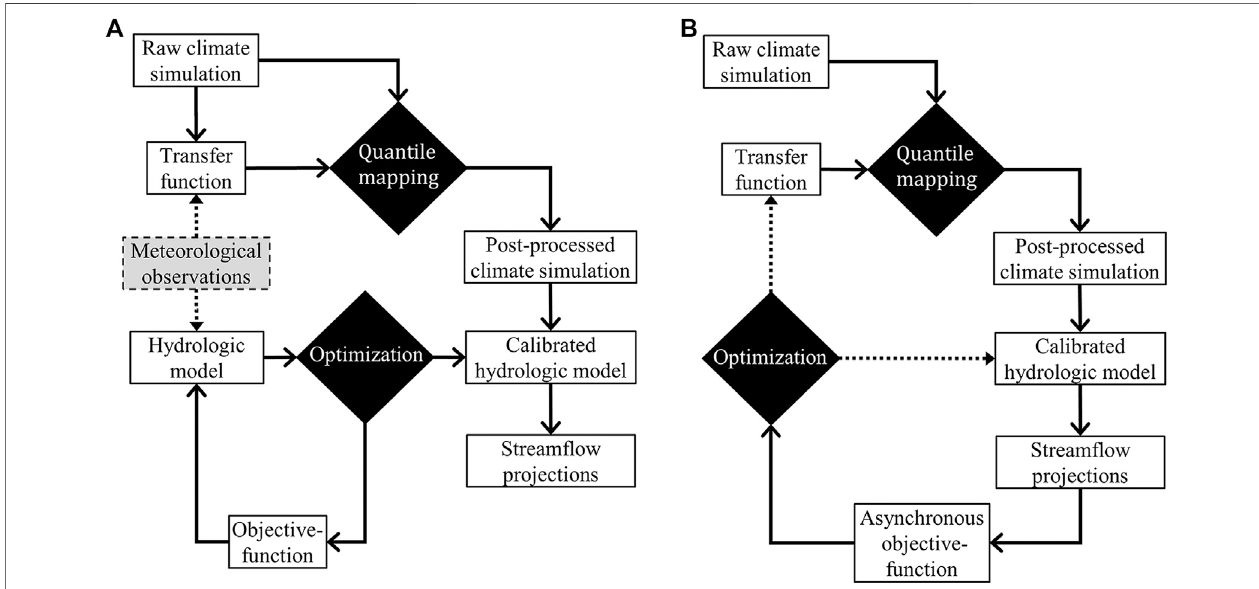
FIGURE1|(A) Aconventionalcon fi gurationofthehydroclimaticmodelingchain. (B) Thesuggestedasynchronouscon fi gurationcircumventingtherequirementfor meteorological observations.